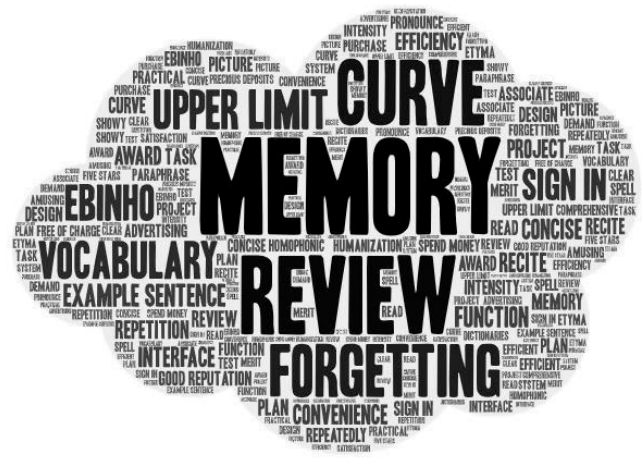
Figure 5. MoMoBeiDanCi general comment word cloud map.